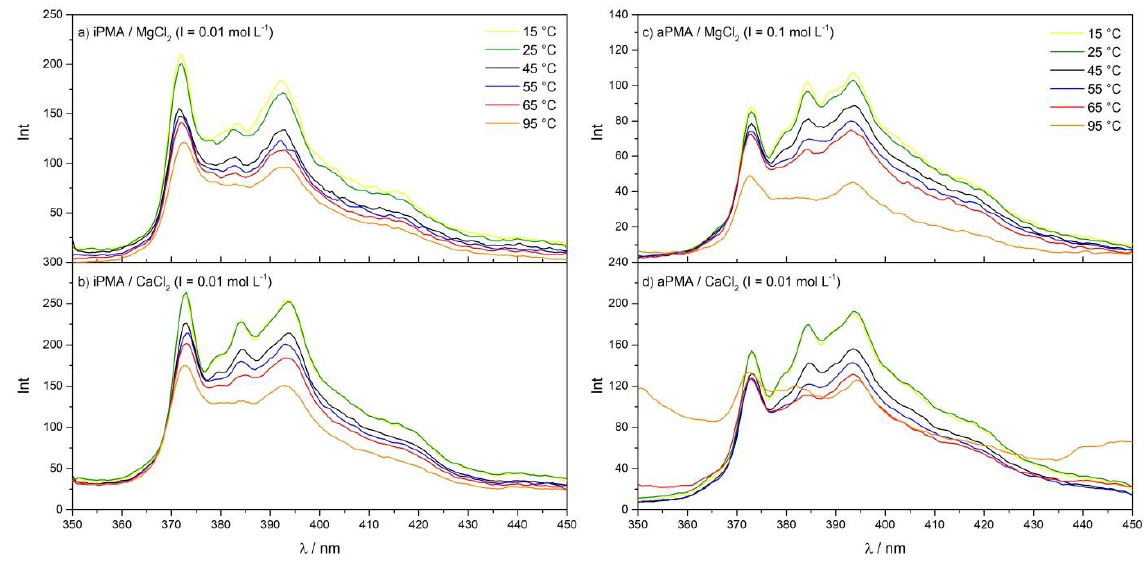
Figure S4. Emission spectra of pyrene for iPMA ( c CaCl (both with I = 0.01 mol L -1 ) and for aPMA ( c 2 (both with I = 0.1 mol L -1 ). Table S8. Effect of temperature on the intensity ratio I fluorescence emission spectra for iPMA ( c